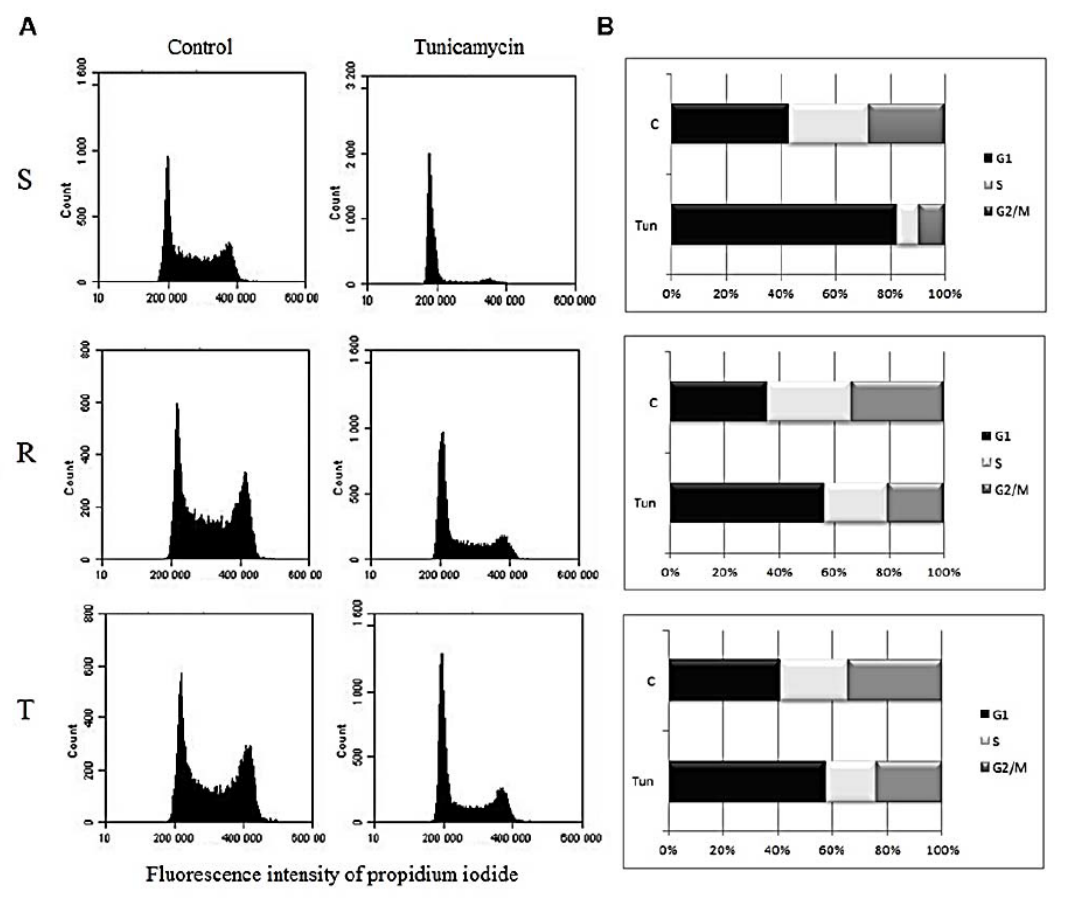
Figure 3. Effect of tunicamycin on the cell cycle of S, R, and T cells after 24-h incubation in culture conditions: ( A ) cell-cycle histograms of cells that were untreated C (control) and treated with tunicamycin for 24 h. ( B ) Summarization of cell cycle phases (G1, S, and G2/M) in column plots: Data are representative of three independent measurements.